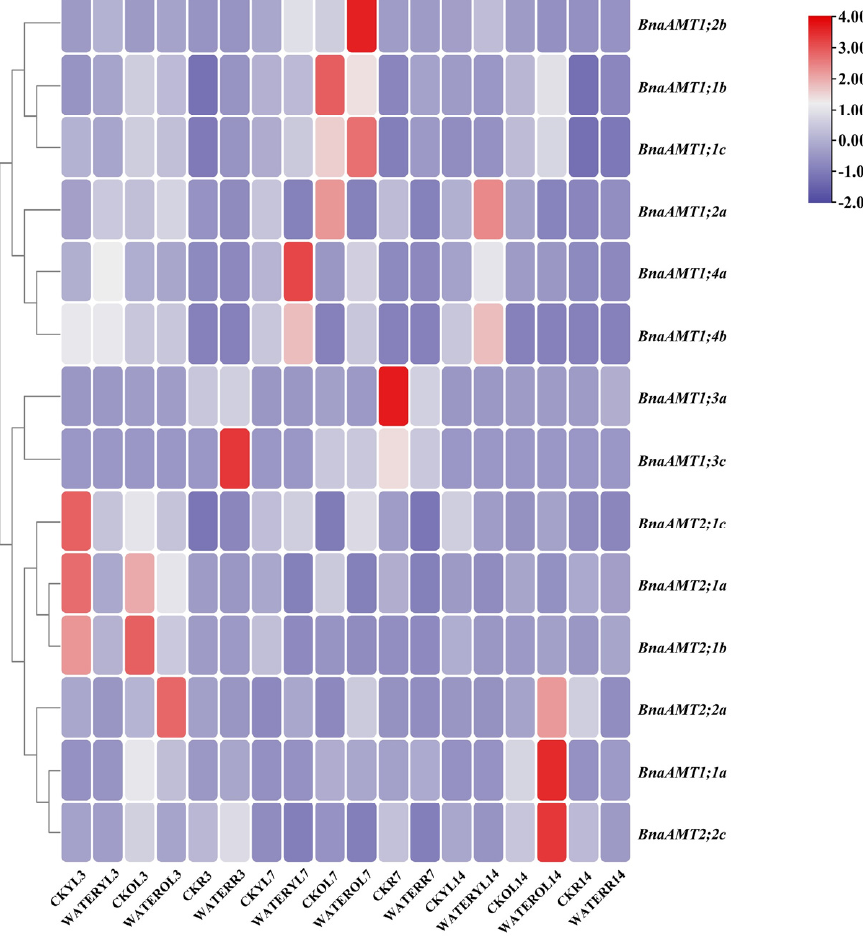
BnaAMT1;1b , BnaAMT1;1c , BnaAMT1;4a , BnaAMT1;5a , and BnaAMT2;2a were separately